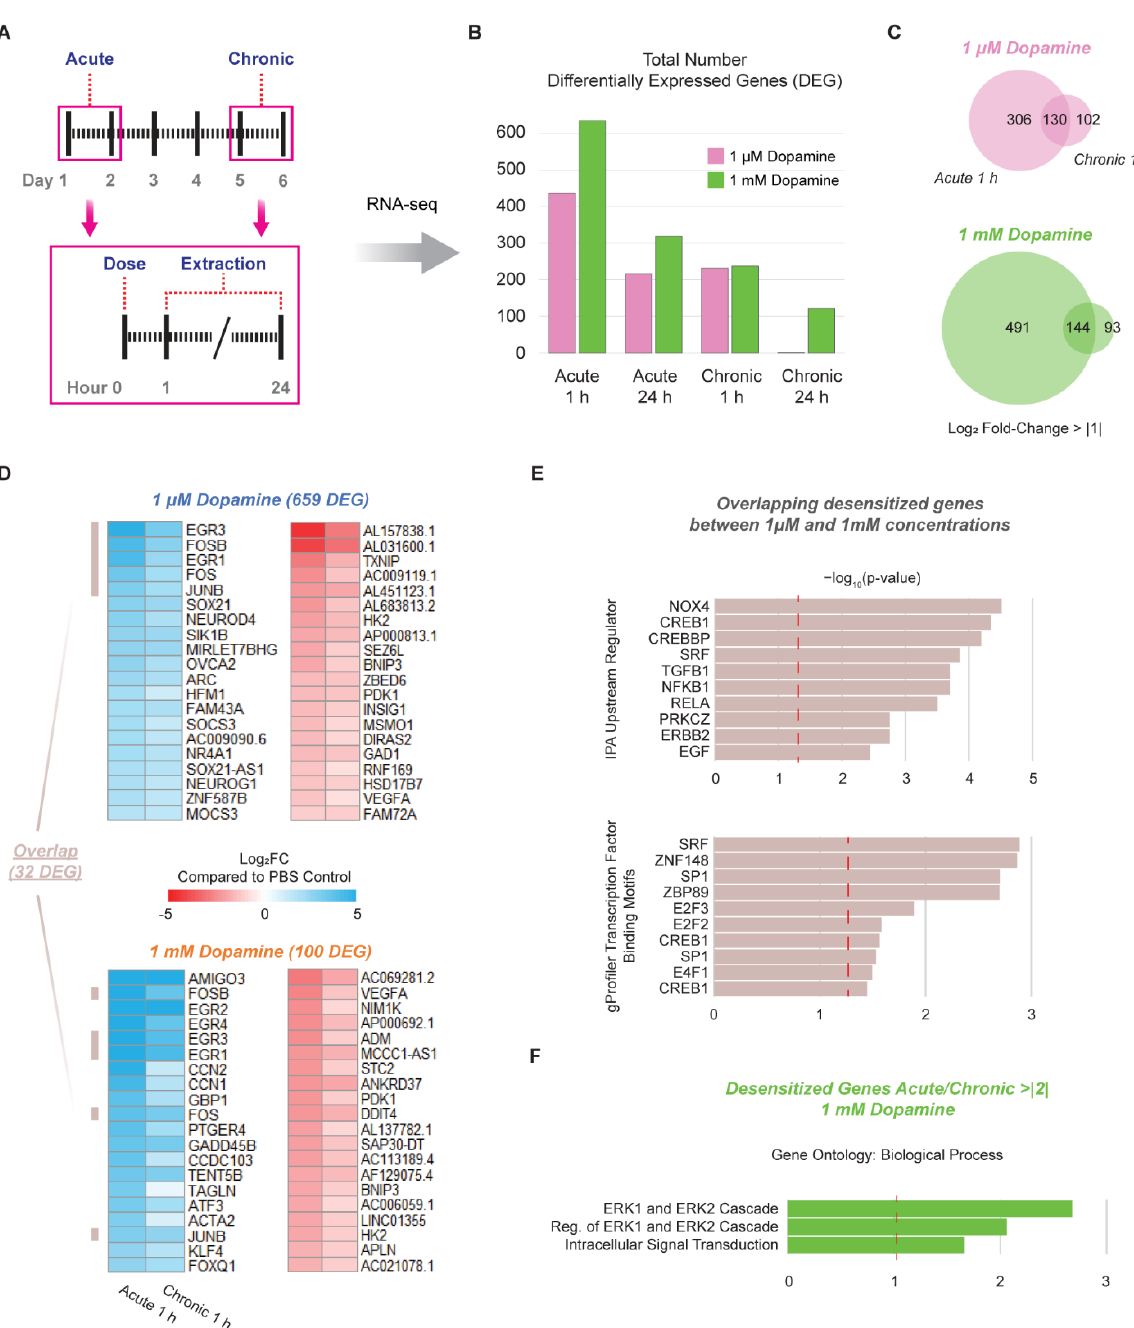
Figure 3. Chronic administration of dopamine leads to desensitization of genes implicated in cocaine and dopamine responses. ( A ) Schematic for isolation of RNA from H9 hMSN-like cells dosed acutely (DIV45) and chronically (DIV50) with dopamine. ( B ) Total number of DEGs from RNA-seq of H9 hMSN-like cells dosed with 1 µM and 1 mM dopamine. ( C ) Venn diagrams showing shared number of DEGs 1 hour after dosage between hMSN-like cells dosed with DIV45 acute and DIV50 chronic dopamine. ( D ) Heatmaps of top 20 desensitized genes for hMSN-like cells exposed to acute and chronic dopamine. Desensitized genes are defined as the ratio of Acute 1 h Log 2 (Fold Change)/Chronic 1 h Log 2 (Fold Change) > |1.1|. Overlapping genes highlighted by tan-colored bars. ( E ) IPA upstream regulators and gProfiler transcription factor regulatory motifs of desensitized genes common between 1 µM and 1 mM dopamine conditions. ( F ) Gene ontology biological processes for highly desensitized genes after chronic 1 mM dopamine, defined when the ratio Acute 1 h Log 2 (Fold Change)/Chronic 1 h Log 2 (Fold Change) > |2|. ( E , F ) Significance is represented by Log 10 -transformed p -values with dotted red line indicating p -value of 0.05. In all cases, data were obtained from RNA-seq of H9 hMSN-like cells. DEGs were identified by max group mean ≥ 0.75,